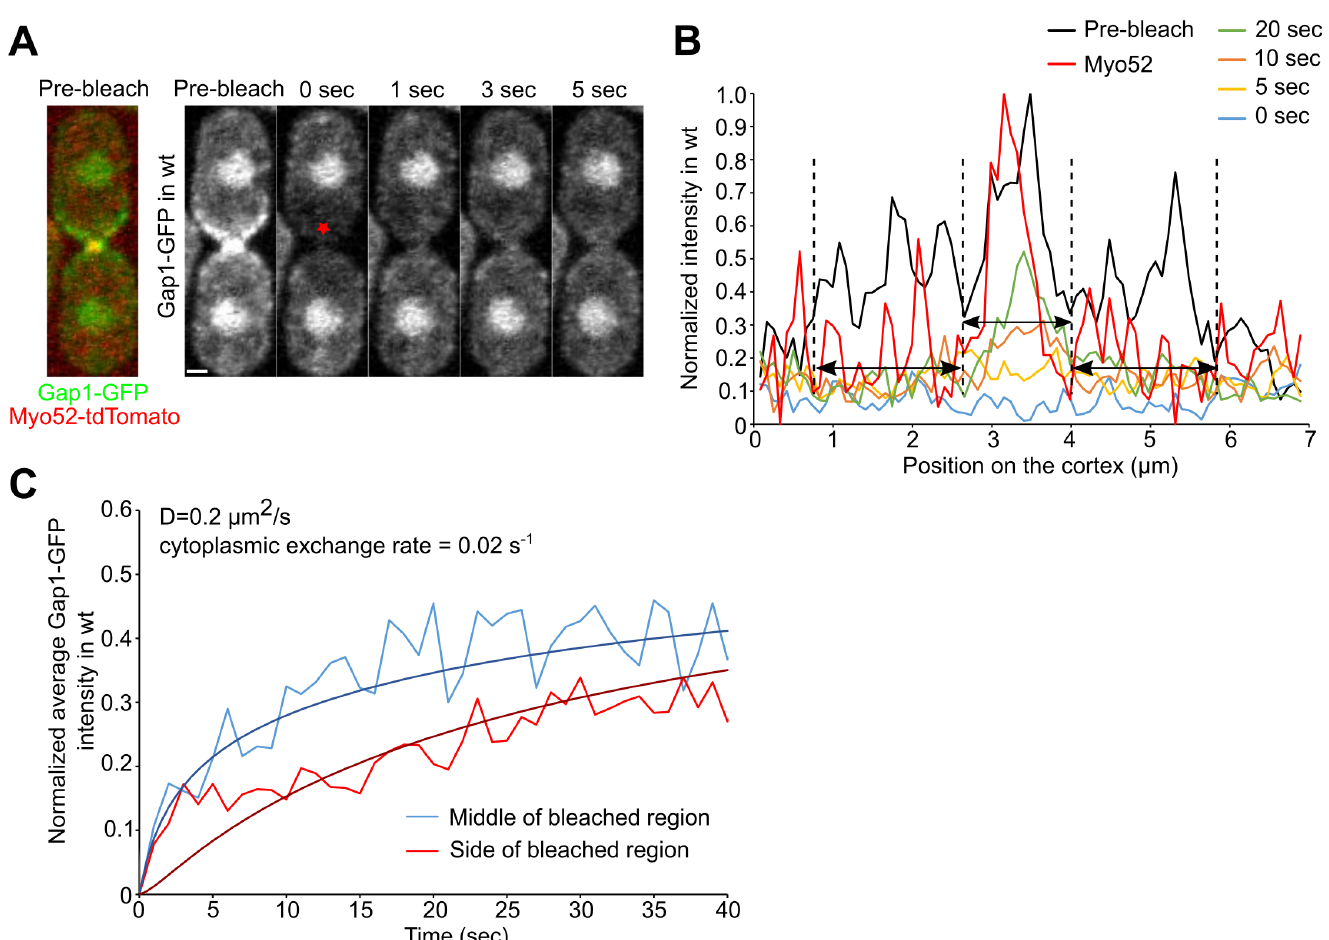
Fig 3. FRAP studies of Gap1 membrane diffusion. (A) Image of WT cells expressing Gap1-GFP and Myo52-tdTomato before bleaching and snapshots of FRAP of Gap1-GFP at the fusion focus (red star). The scale bar is 1 μ m. (B) Intensity profile along the cell cortex at the indicated time points for the top cell in panel A. The Myo52-tdTomato intensity profile, as shown in panel A, is used to identify the center and the sides of the bleached region (black arrows). (C) Average recovery of Gap1-GFP for the cell shown in panel A at the middle and the sides of the bleached region as indicated by black arrows in panel B. The fits correspond to model with recruitment of Gap1-GFP to the cell tip (where the Myo52 zone is assumed to exist) with 50% recovery at long times. Good fits were obtained for D ¼ 0 : 1 (cid:0) 0 : 3 m m 2 s (cid:0) 1 and r ¼ 0 : 015 (cid:0) 0 : 025 s (cid:0) 1 .